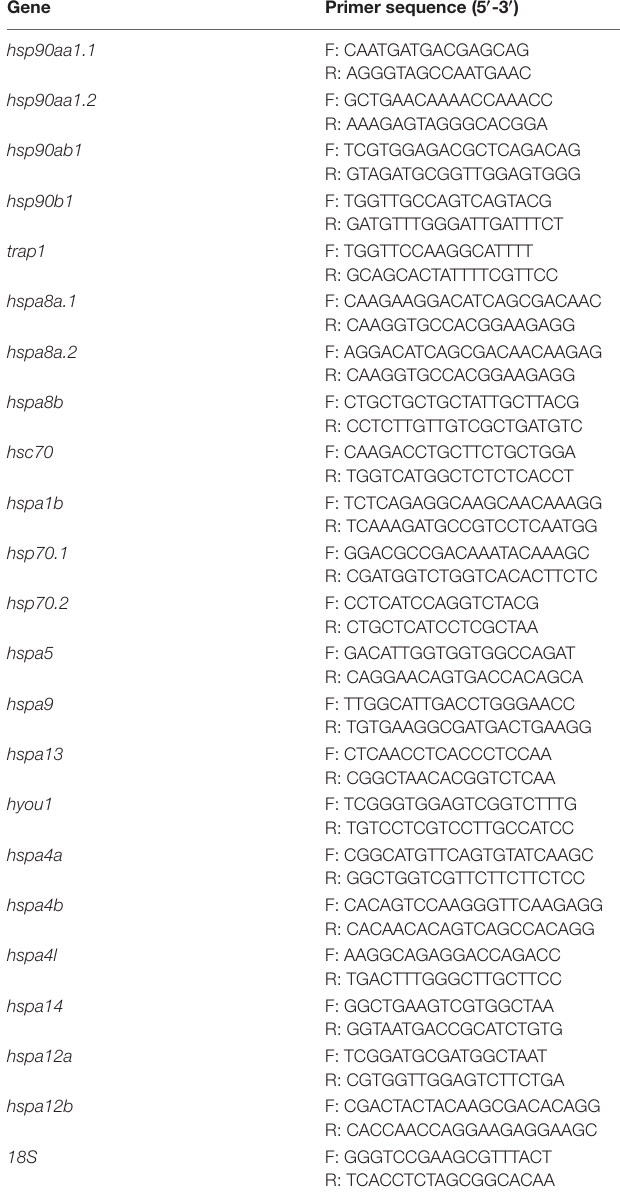
TABLE 1 | Primers used for quantitative real-time PCR (qPCR).